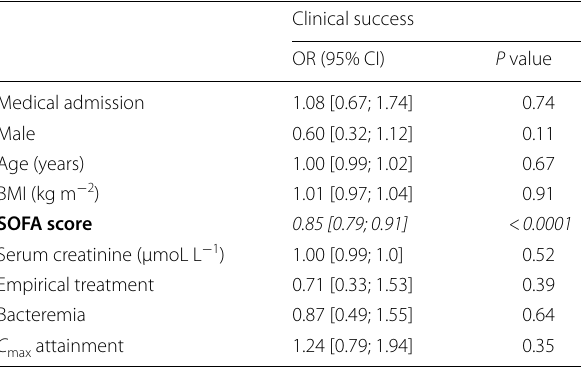
Italic values indicates P values <0.05